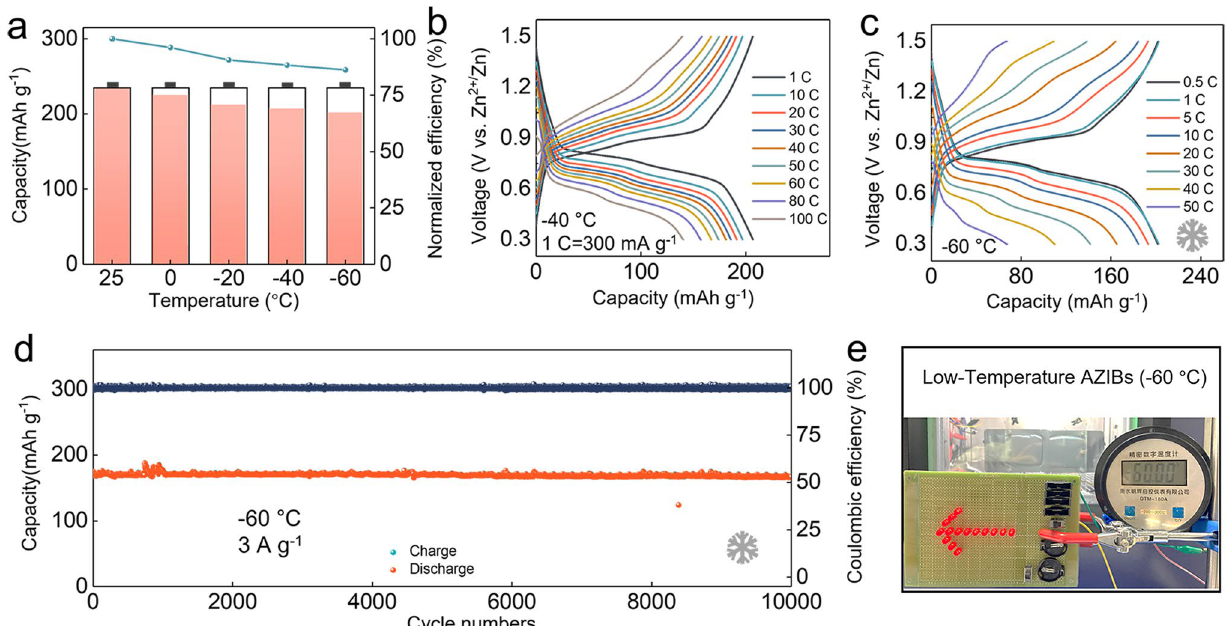
Fig. 6 The low-temperature electrochemical performance of Zn//4S6Q. a Discharge capacity of Zn//4S6Q battery at different temperatures (at 150 mA g −1 ). b GCD curves of Zn//4S6Q battery at different current densities under − 40 °C. c GCD curves of Zn//4S6Q battery at different current densities under − 60 °C (1 C = 300 mA g −1 ). d Cycling stability of Zn//4S6Q battery at 3 A g −1 under − 60 °C. e Optical image of